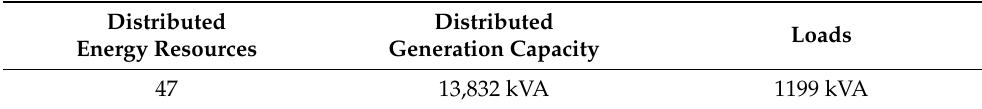
Table 3. System data of the Jeong-Eup D/L distribution networks.